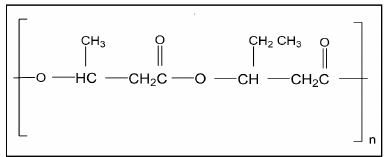
Figure 2. Chemical structure of the poly(3-hydroxybutyrate- co -3-hydroxyvalerate) copolymer. Table 1. Physical properties of polyhydroxybutyrate (PHB) and poly(3-hydroxybutyrate- co -3- hydroxyvalerate) (PHBV). Reproduced with permission from Ref. [53].